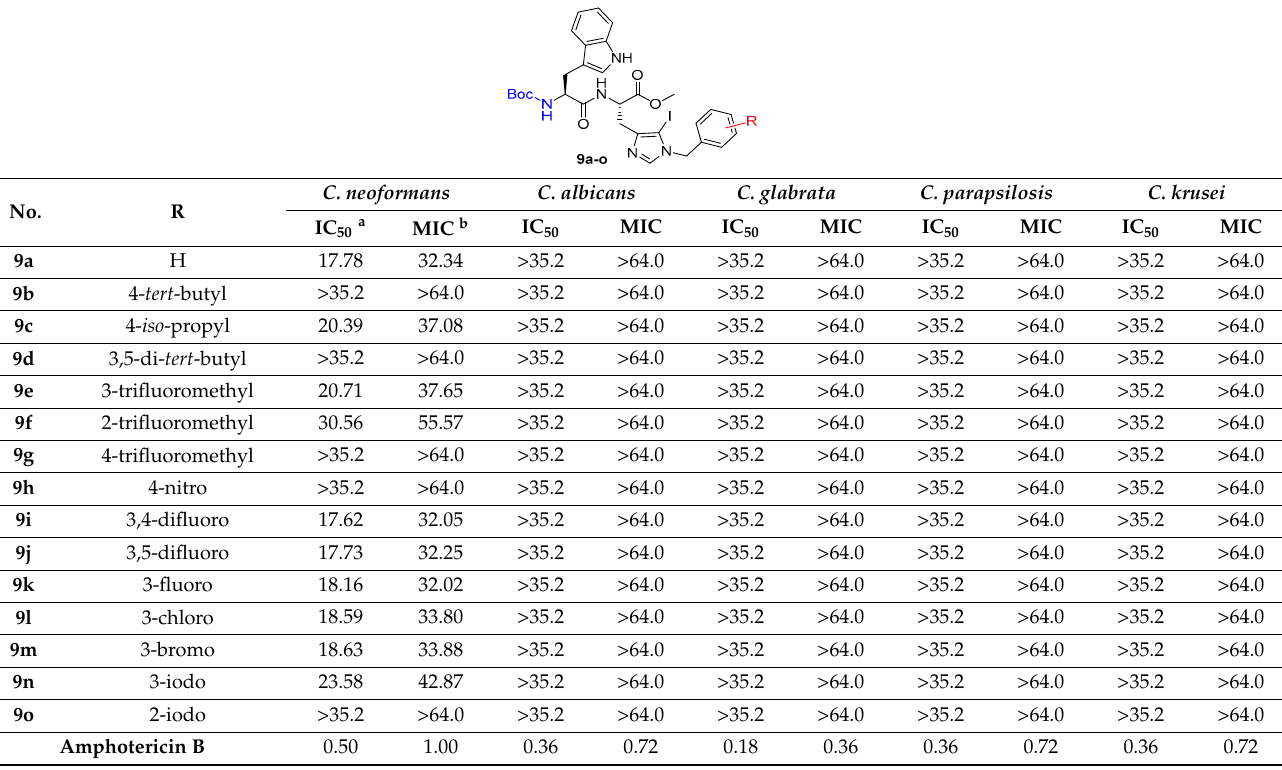
Table 1. In vitro antifungal screening of peptides (Series 1).